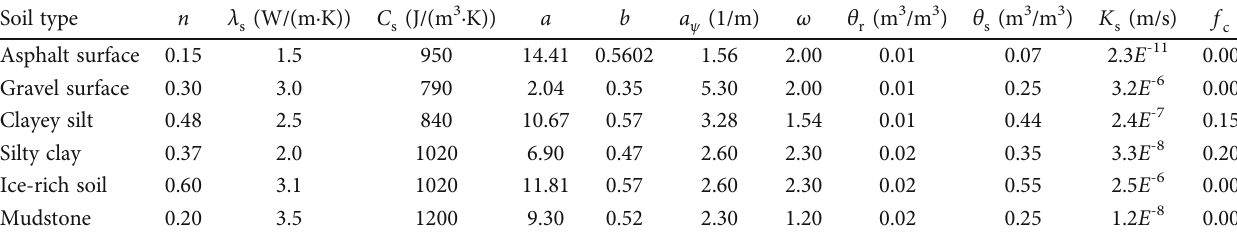
Table 3: Soil-layer thermal-moisture parameters of the underlying surface